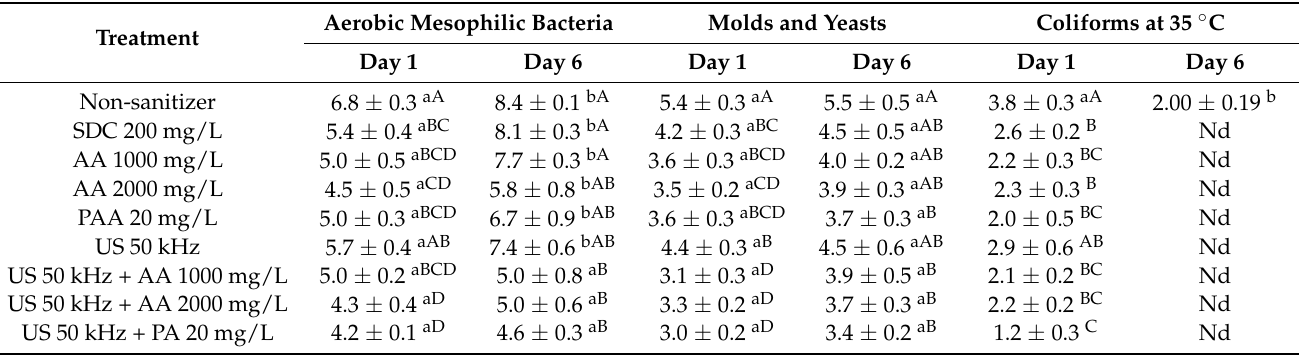
Table 1. Average and standard deviation of aerobic mesophilic bacteria, molds, yeasts, and coliforms at 35 ◦ C counts (log CFU/g) in kale samples after sanitization and over storage at 7 ◦